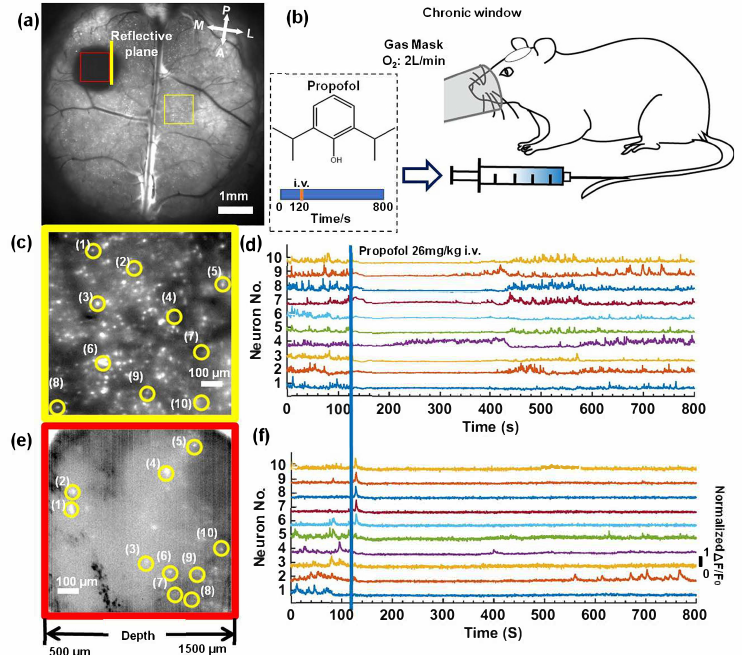
Figure 6. Deep in vivo functional imaging of mouse brains anesthetized by propofol. ( a ) The standard deviation projection of 600 time-lapse images of the mouse brains. Scale bar: 1mm. ( b ) A schematic diagram of the experiment. ( c , e ) Magnified views of the subregions marked in ( a ). Scale bar: 100µm. ( d , f ) Fluorescence signal fluctuation ( ∆ F/F 0 ) for neurons in yellow circles in ( c , e